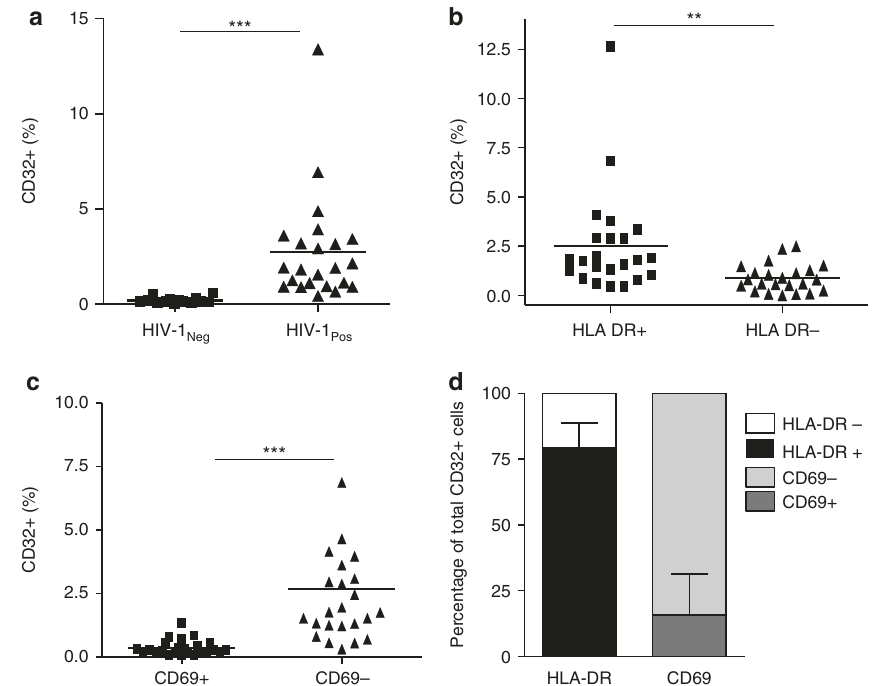
Fig. 2 CD32 expression is associated to HLA-DR in CD4 + T cells from HIV-1 + individuals. a Expression of cell surface CD32 measured by fl ow cytometry in CD4 + T cells from uninfected donors (HIV-1 Neg ) and HIV-1 + individuals (HIV-1 Pos ). b and c Percentage of CD32 + cells in HIV-1-infected individuals co- expressing HLA-DR ( b ) or CD69 ( c ). CD32 cell surface expression was measured in 23 HIV-1 + individuals by fl ow cytometry in combination with the HLA- DR (left panel) or CD69 (right panel) activation markers. d Contribution of the HLA-DR and CD69 cells to the CD32 compartment in CD4 + T cells from HIV-1 + individuals. The data represent the mean ± SD from uninfected donors ( N = 14) and HIV-1 + individuals ( N = 23). Student ’ s t -test, ** p < 0.01, *** p < 0.001. The gating strategy used to identify CD32 + cells is shown in Supplementary Fig. 4. CD32 expression for each HIV + individual is shown